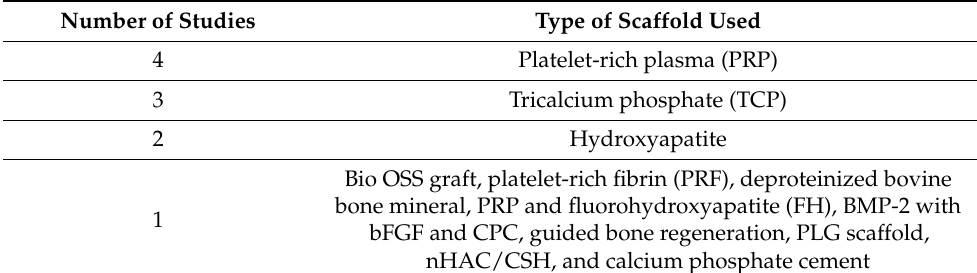
Table 3. Characterization of scaffold used.